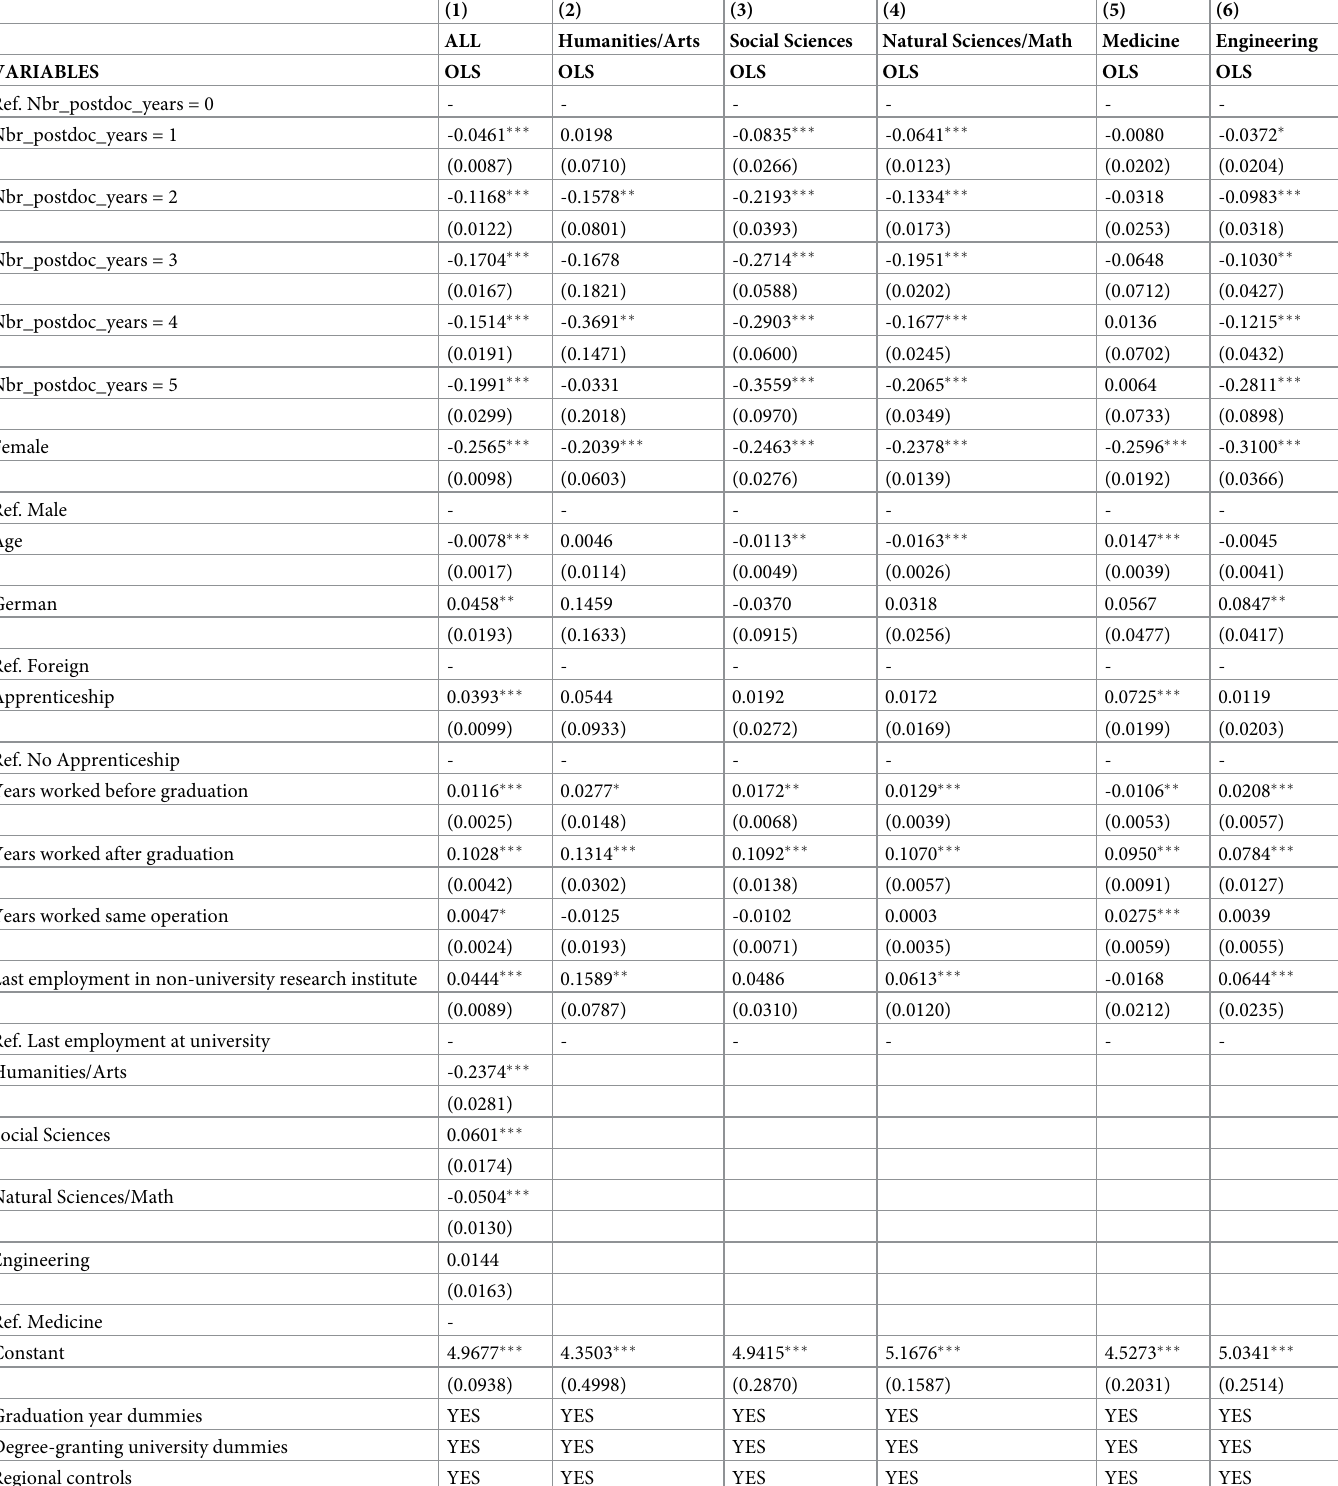
Table 2. OLS regression of doctorate recipients’ daily log imputed income 5 years after